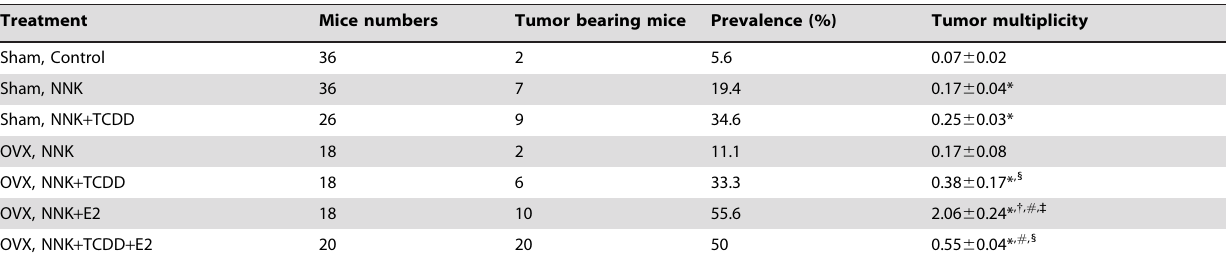
Table 2. The incidence and lung tumor multiplicity of lung tumor formation in A/J mice treated with NNK, NNK combined with TCDD, E2, or